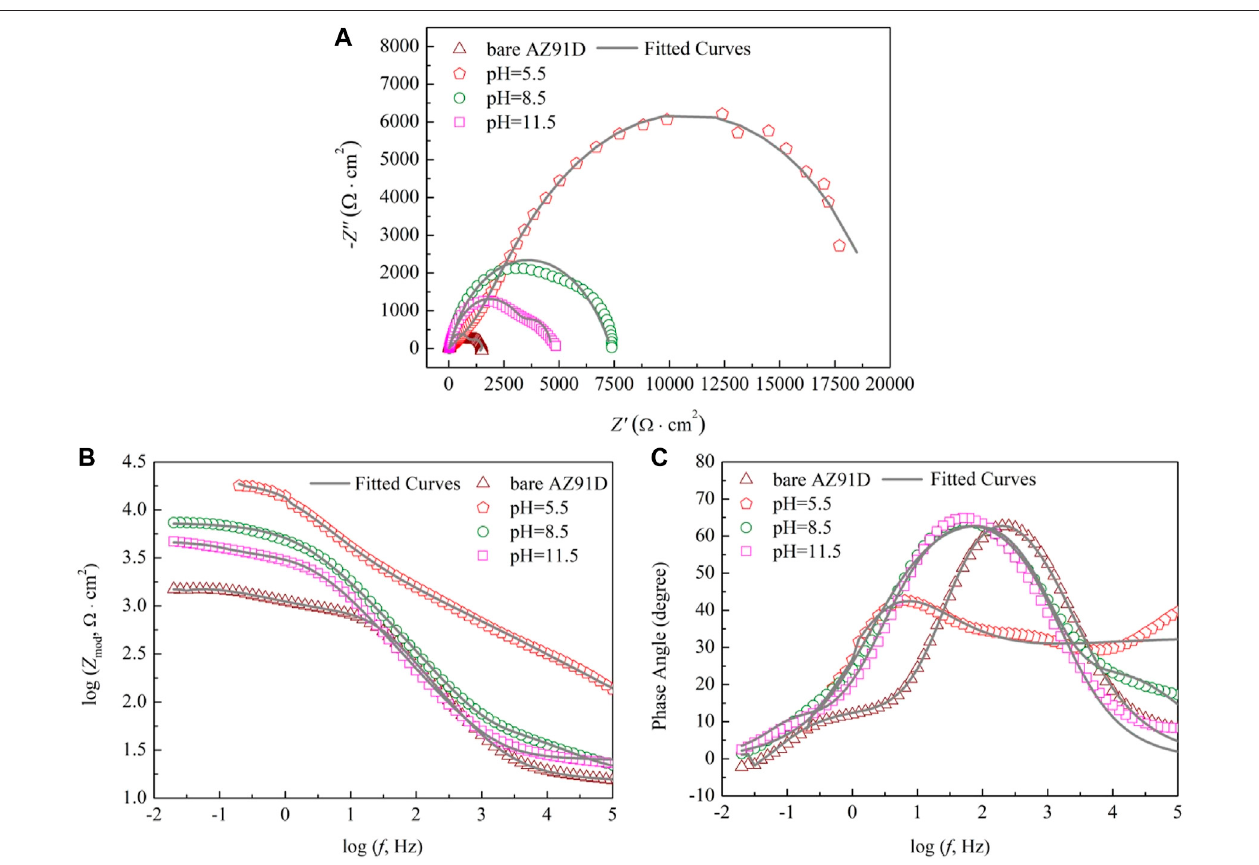
FIGURE 7 | Impendence spectra of bare AZ91D and coated samples: (A) Nyquist plots, (B) Bode plots of log Z mod vs log f and (C) Bode plots of phase angle vs log f .